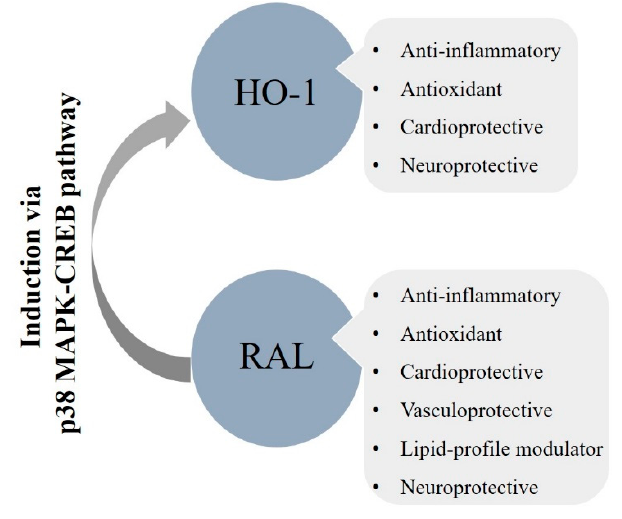
Figure 3. Overall cardiometabolic and neuroprotective e ff ects of RAL involving the HO-system; HO-1: heme-oxygenase-1, RAL: raloxifene, p38 MAPK: p38 mitogen-activated protein kinase, CREB: cAMP-responsive element-binding protein.